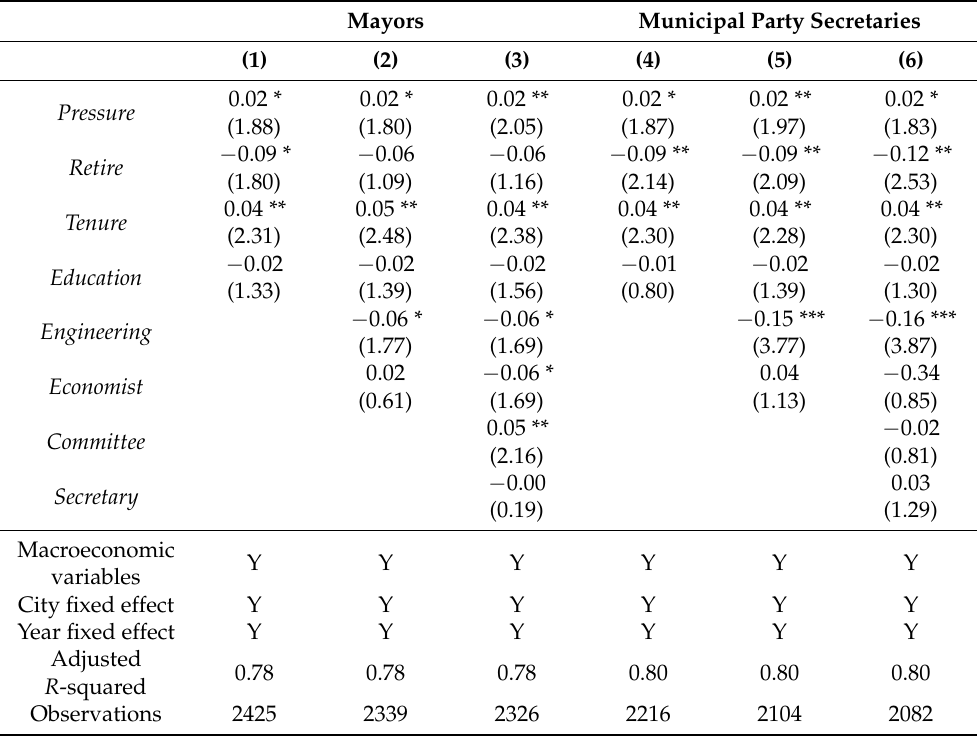
Table 2. Promotion pressures of local leaders and real estate